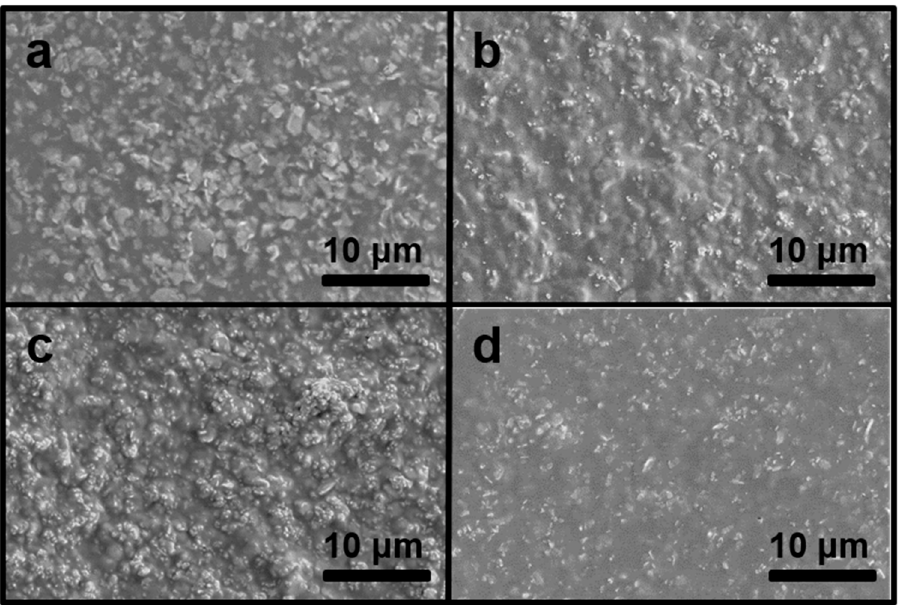
Figure 2. SEM observation of HPMC/MoS 2 /Al composites: ( a ) HPMC/MoS 2 , ( b ) Al 1 wt.%, ( c ) Al 2 wt.%, and ( d ) Al 3 wt.%.